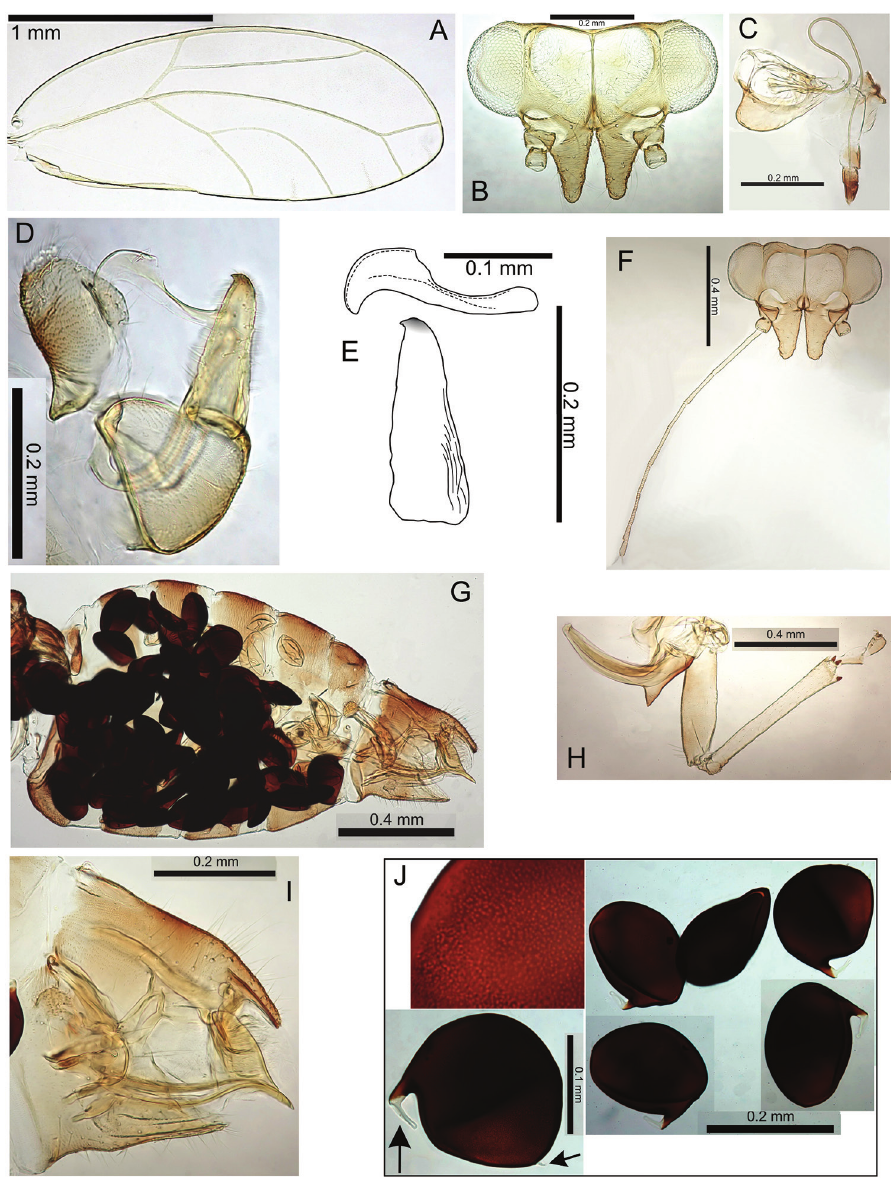
Figure 37. Pariaconus hualani sp. n. A fore wing B head C proboscis D male terminalia E aedeagus and paramere F head and antenna G female abdomen (with eggs) and terminalia H hind leg I female terminalia J eggs (pedicel and tail indicated, microsculpturing